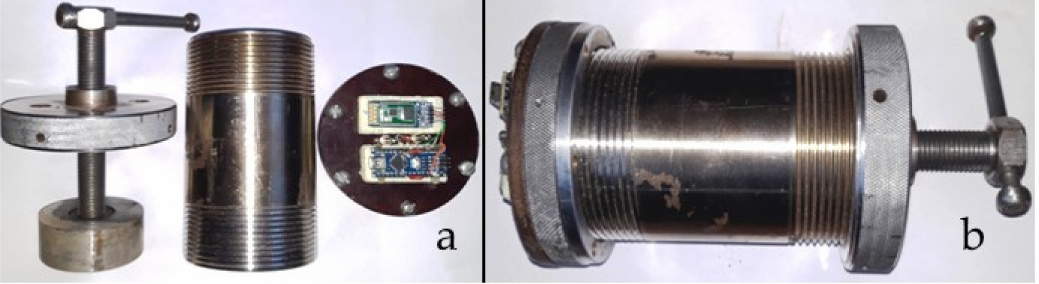
Figure 4. Soil humidity measuring device: ( a )—constituent elements; ( b )—general